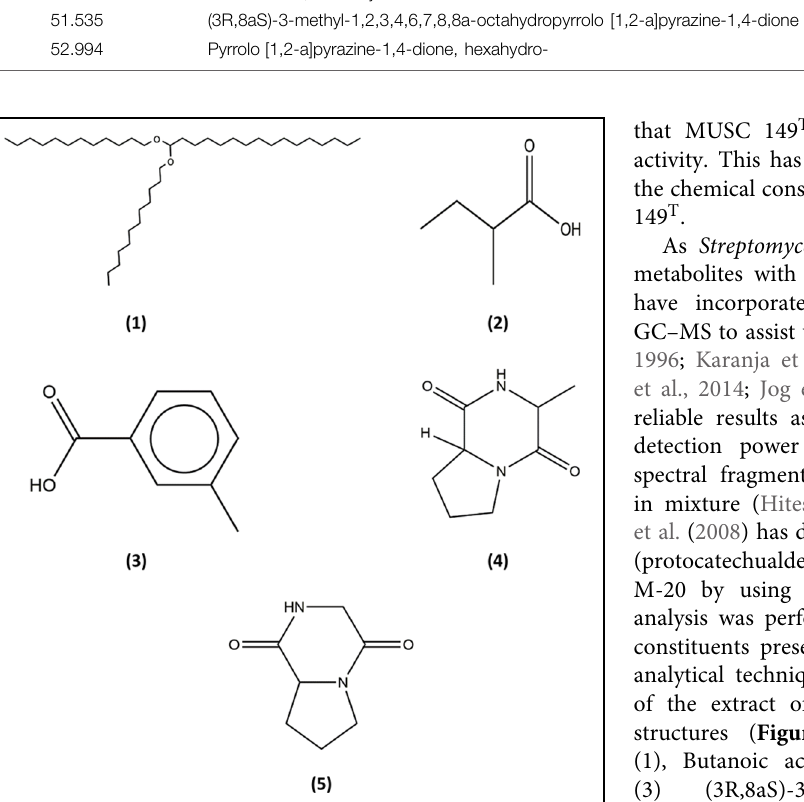
FIGURE 5 | Chemical structures of the identified compounds from MUSC 149 T . (1) Hexadecane, 1,1-bis(dodecyloxy); (2) Butanoic acid, 2-methyl-; (3) Benzoic acid, 3-methyl-; (4) (3R,8aS)-3-methyl- 1,2,3,4,6,7,8,8a-octahydropyrrolo[1,2-a]pyrazine-1,4-dione; (5) Pyrrolo[1,2-a]pyrazine-1,4-dione,